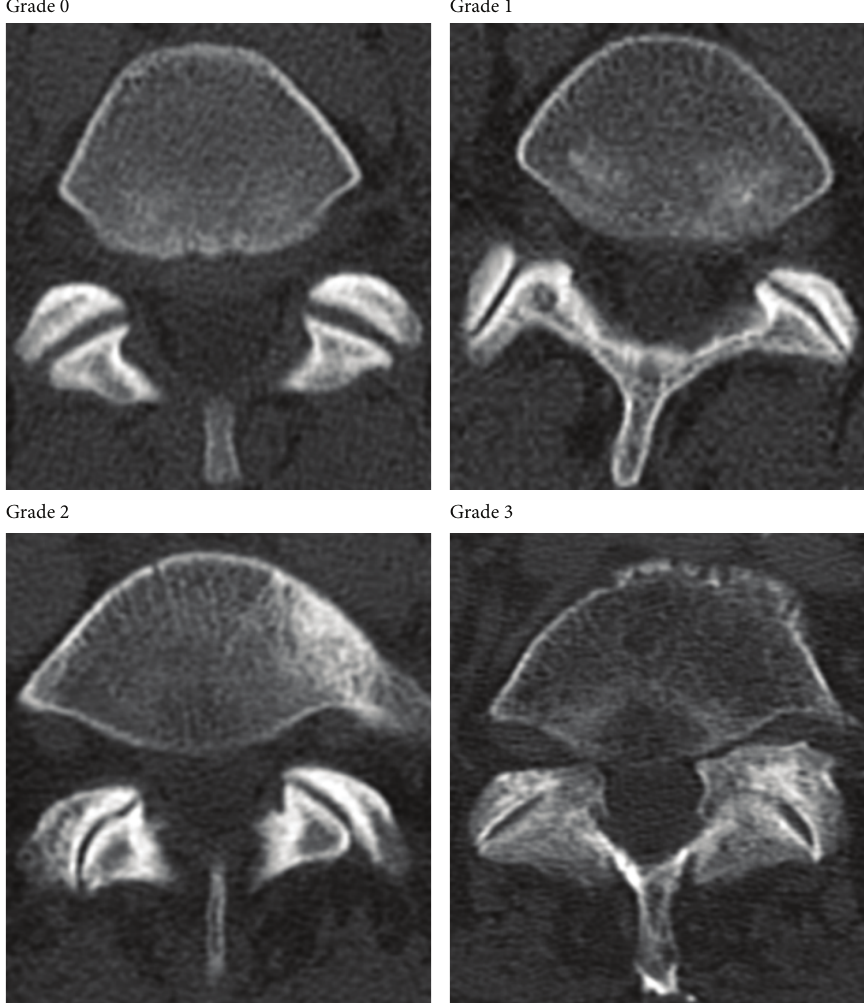
Figure 1: Grading scale for FJ arthritis. Grade 0 = normal FJ. Grade 1 (mild) = joint space narrowing, grade 2 (moderate) = sclerosis, and grade 3 (severe) =